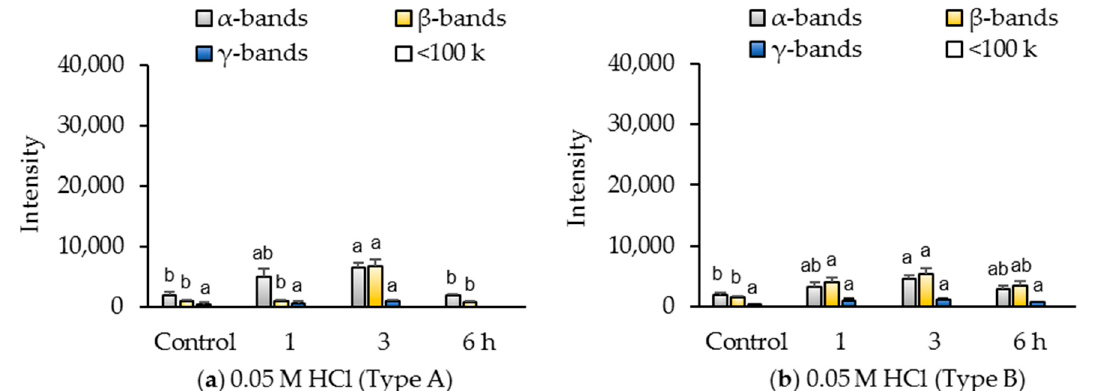
Figure 3. Effects of the decalcification period on the intensities of α -, β -, γ -, and low molecular-weight (<100 k) bands of gelatin in the re-extracts in SDS-PAGE (7.5% gel). Gelatins were re-extracted from the Type-A extracted residues ( a ) and Type-B extracted residues ( b ) of the mixed tissue from Kalamtra head after the decalcification in 0.05 M HCl. Control groups were re-extracted without decalcification. Each lane contained 3 µL extract. Columns and bars represent means and standard errors of three replicates, respectively. Different letters in each band indicate a significant difference ( p < 0.05). Table 3. Yields (%, dry weight gelatin / wet weight sample) of gelatins after decalcification of extracted residues from the mixed tissue of the Kalamtra sturgeon head using 0.05 M HCl at di ff erent times. Extraction Conditions Decalcification Yields (%) Gelatin Decalcification Time (h) pH Temperature ( ◦ C) Time (h)